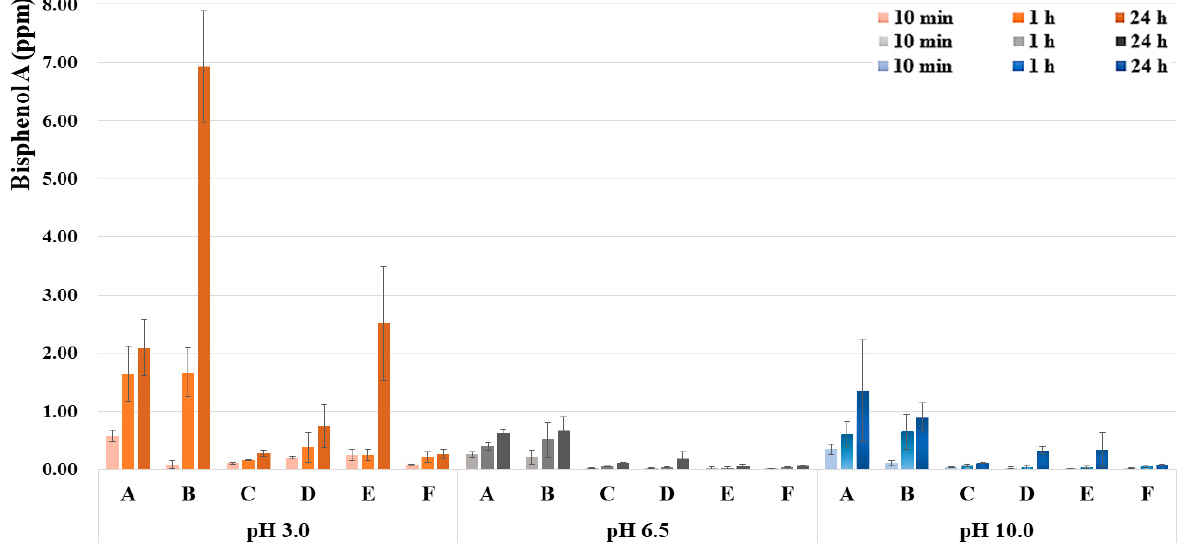
Figure 3. Comparison of BPA concentration (ppm) according to pH levels ( p < 0.05) and time ( p